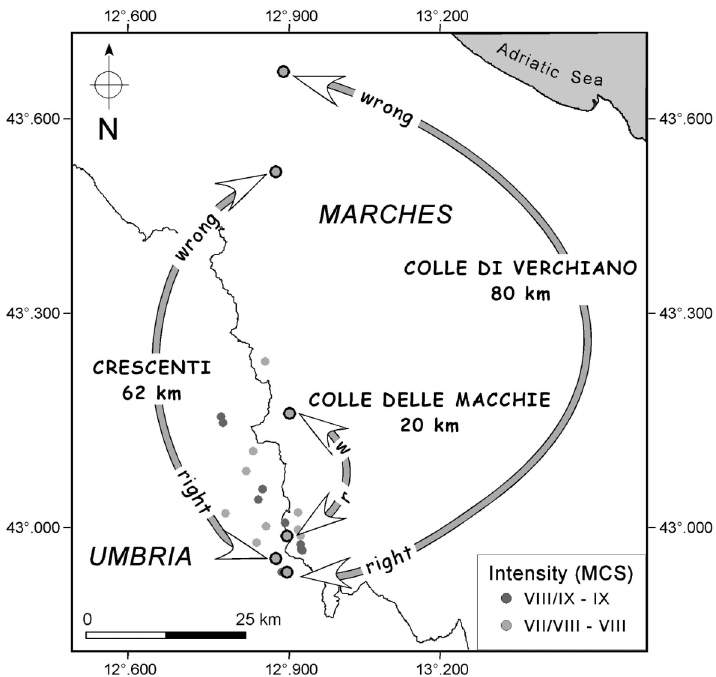
Fig. 3 . Different locations of three damaged localities, according to Camassi et al. (1998) and Boschi et al.